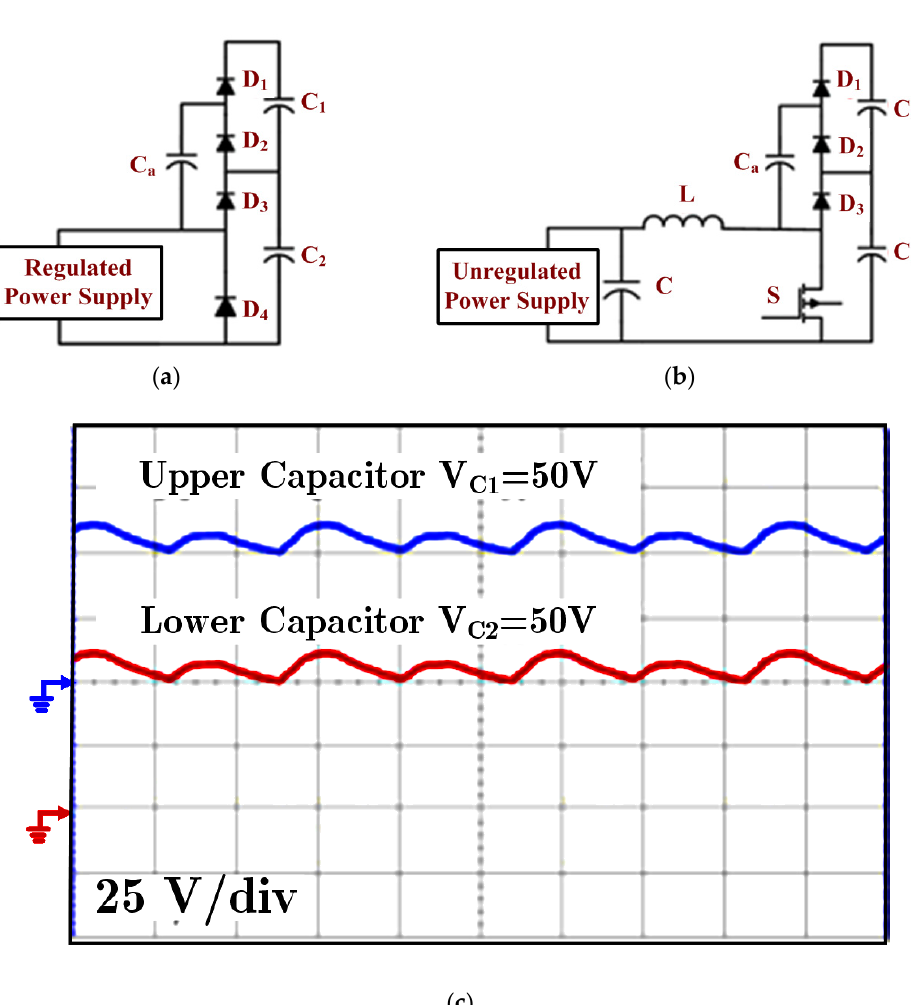
Figure 14. Circuit diagram of the voltage divider ( a ) For regulated dc sources, ( b ) For unregulated dc sources, ( c ) Capacitors’ balanced waveforms for the 25-Level: second unit.